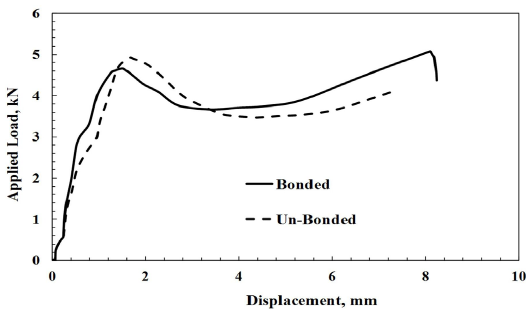
Figure 16. Effect of interface conditions on the flexural strength of sandwich composites measured from SPT